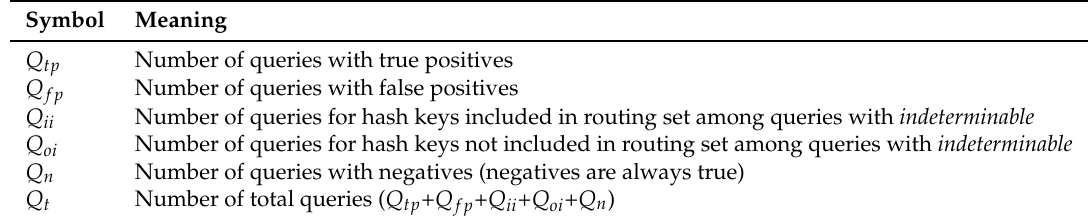
Table 6. Notation and definition of query